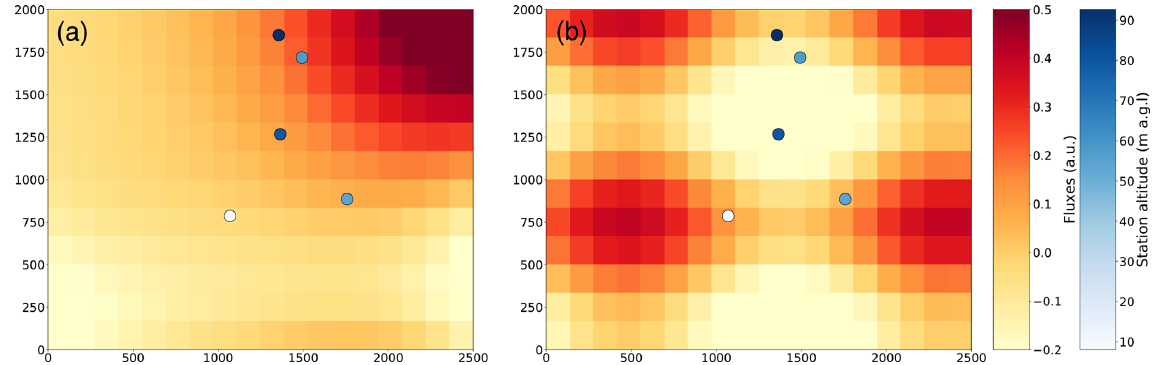
Figure 4. (a) Prior fluxes and observation sites. (b) Perturbation from the prior data used to generate “true” observations. Observation sites are shown as circles coloured according to their height in metres above ground level (ma.g.l.). Fluxes are reported in arbitrary units